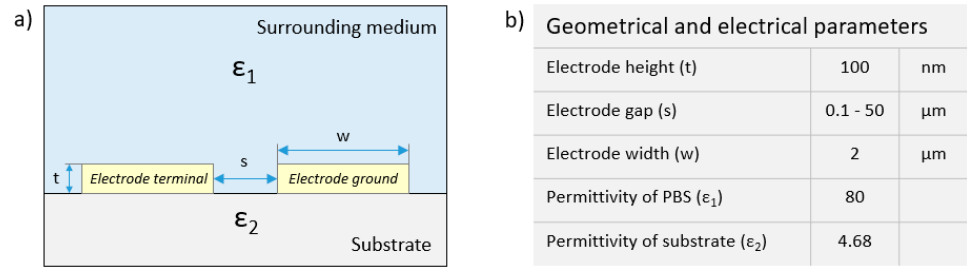
Figure 1. ( a ) Simplified 2D model of a blank finger pair of the IDA structure, not drawn to scale ( b ) Geometrical and electrical parameters used for the